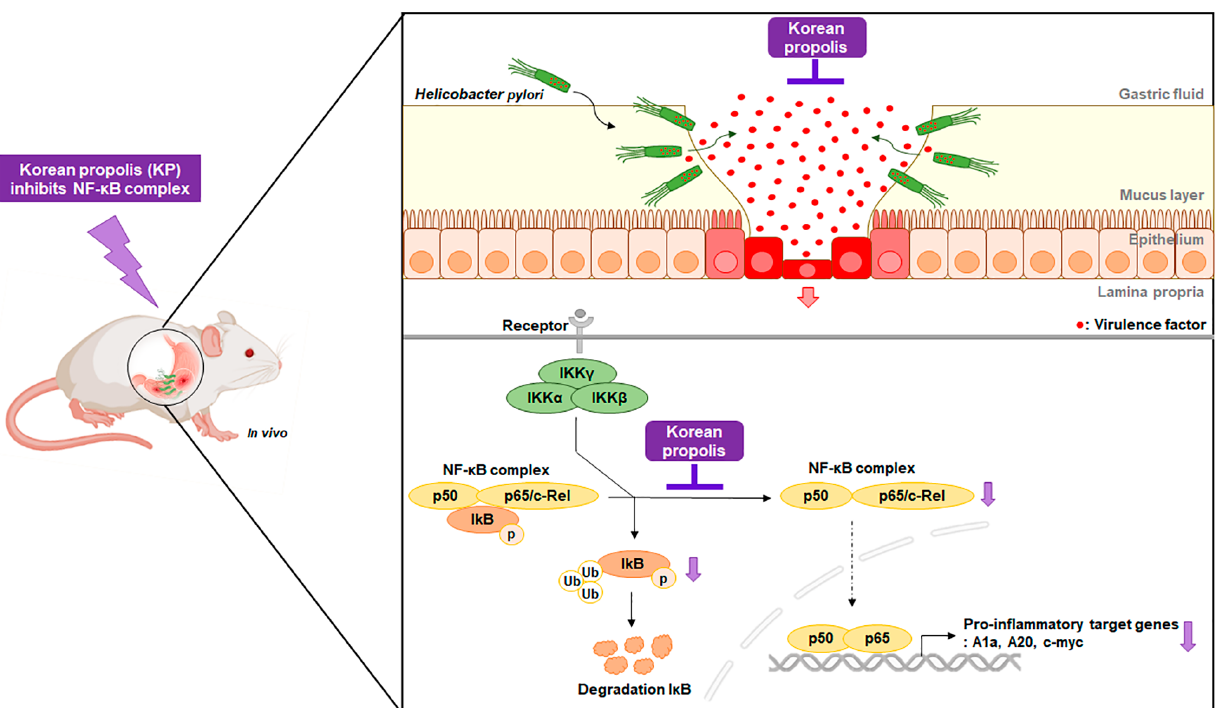
Figure 5. Schematic representation depicting KP inhibition of NF- κ B-mediated inflammation in H. pylori -infected gastric mucosal injury in mice. “Black color ↓ ” indicates induction; “Purple color ↓ ” indicates reduction; “ ├ ” indicates inhibition.